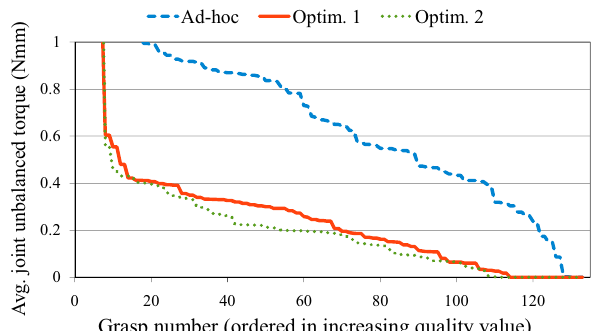
Fig. 7. TWO GRASPS (CENTERED AND ASYMMETRICAL) EXECUTED WITH THE PROTOTYPE GRIPPER.